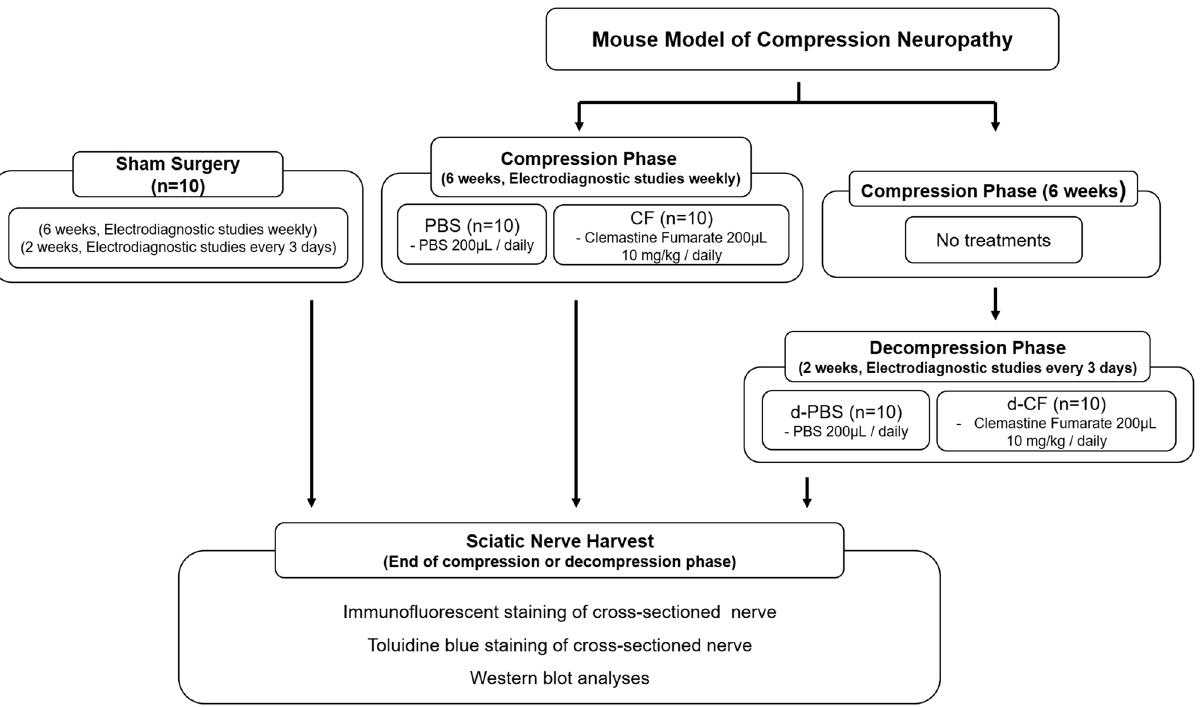
Figure 6. Scheme of experimental design. (PBS, control mice treated with phosphate buffered saline during compression phase; CF, mice treated with clemastine fumarate during compression phase; d-PBS, control mice treated with phosphate buffered saline after decompression phase; d-CF, mice treated with clemastine fumarate after decompression phase; n =